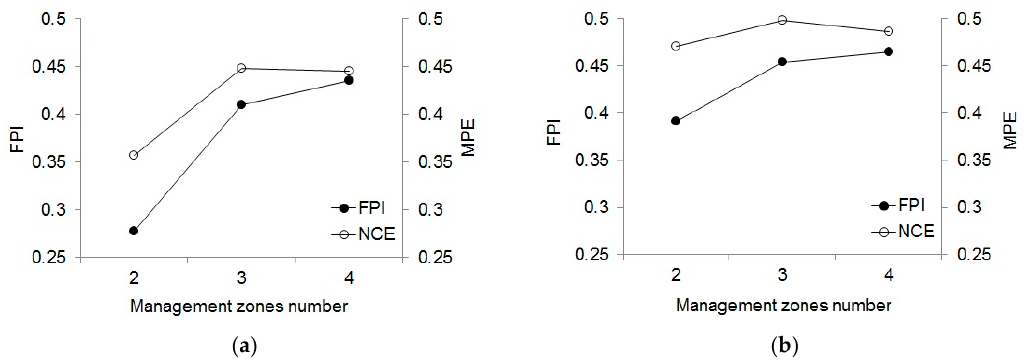
Figure 5. Fuzzy Performance Index (FPI) and Modified Partition Entropy (MPE) calculated for the management zone from combination between clay + elevation + flow vector ( a ) and clay + elevation ( b ).